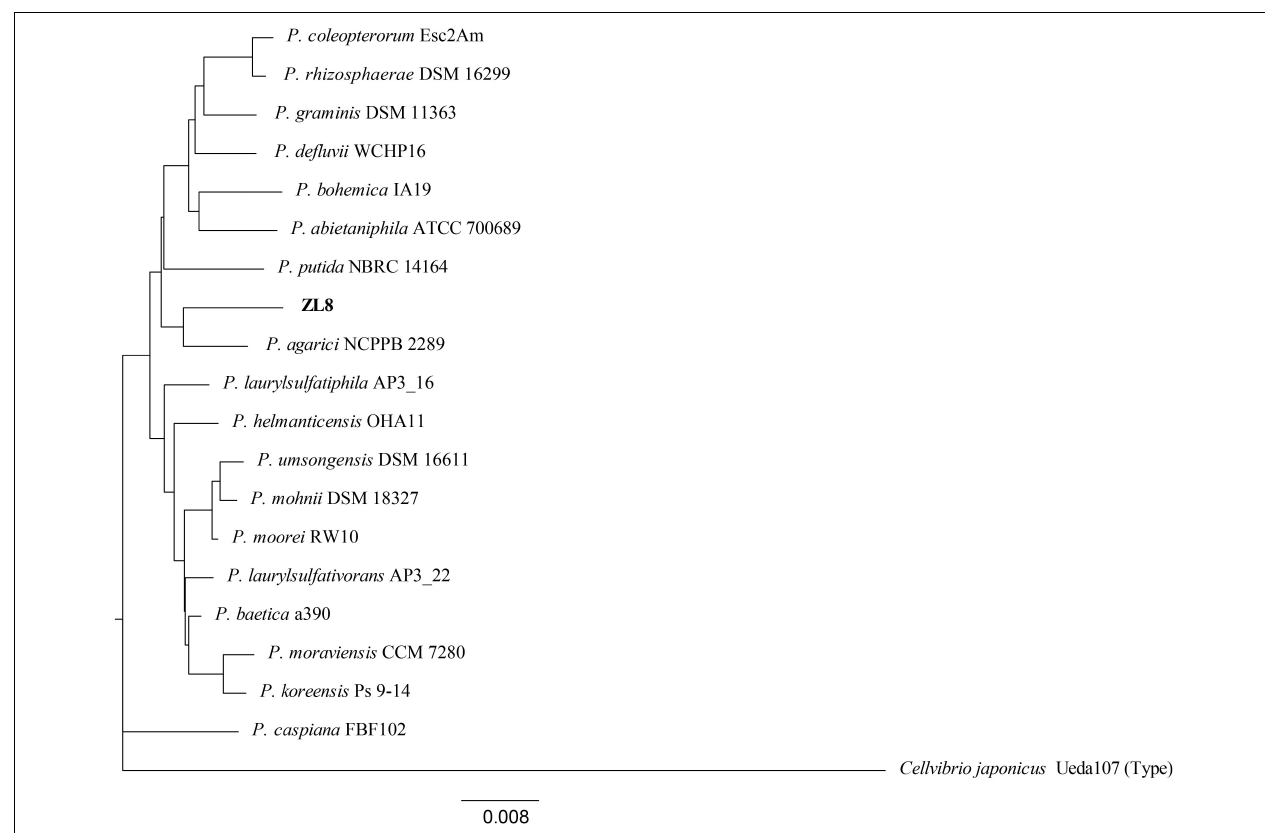
FIGURE 2 | Phylogenetic tree of the strain ZL8 and its close relatives based on 16S rRNA gene sequencing. Dendrograms were generated by the neighbor-joining method. Cellvibrio japonicus Ueda 107T was used as outgroup. The bar indicates sequence divergence. Percentage bootstrap values of more than 50% (from 1000 replicates) are indicated at the